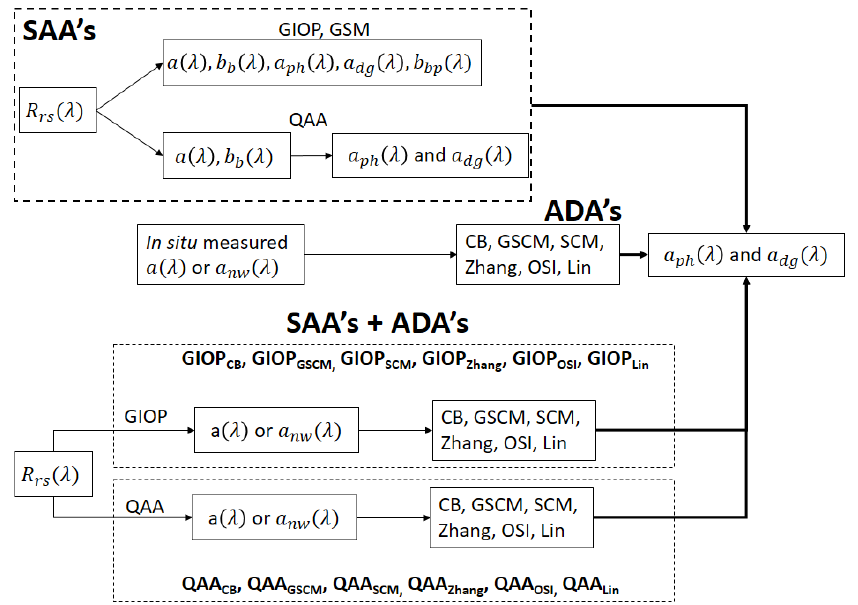
Figure 1. Semi-analytical Algorithms (SAAs) use R rs ( λ ) and provide bulk and subcomponent IOPs as outputs. Absorption decomposition algorithms (ADAs) derive absorption subcomponents from total or non-water absorption coefficient. In hybrid SAA ADA models, a nw ( λ ) from an SAA is input to ADA to derive absorption subcomponents.